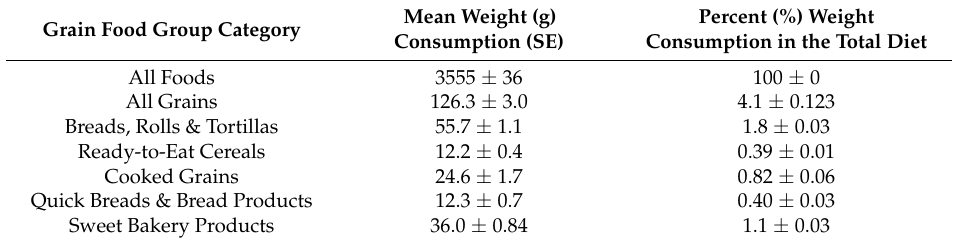
Table 1. Grain categories identified from the National Health and Nutrition Examination Survey (NHANES) 2009–2012 in adults ( ≥ 19 years-old; n = 10,697; gender combined) by mean (SE) gram weight and percent weight (SE) in total